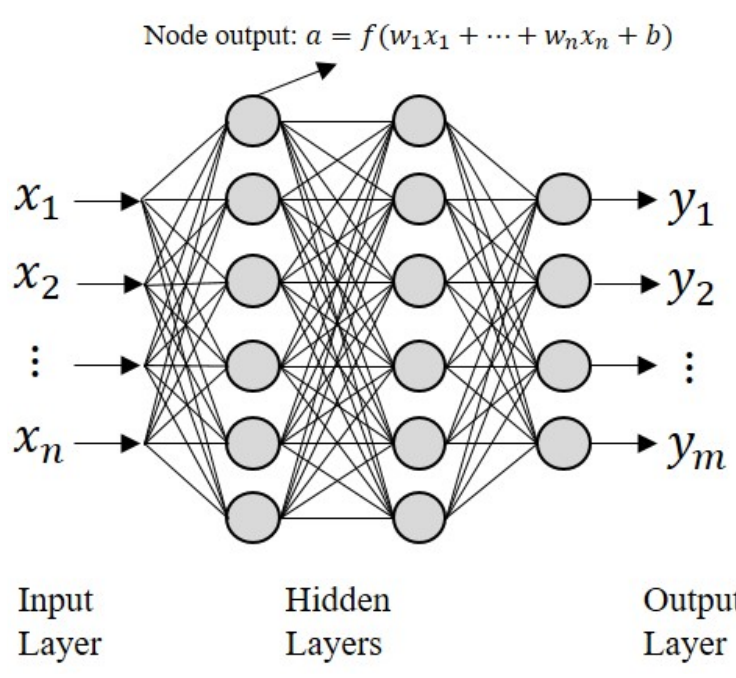
Figure 12. Structure of multilayer perceptron.